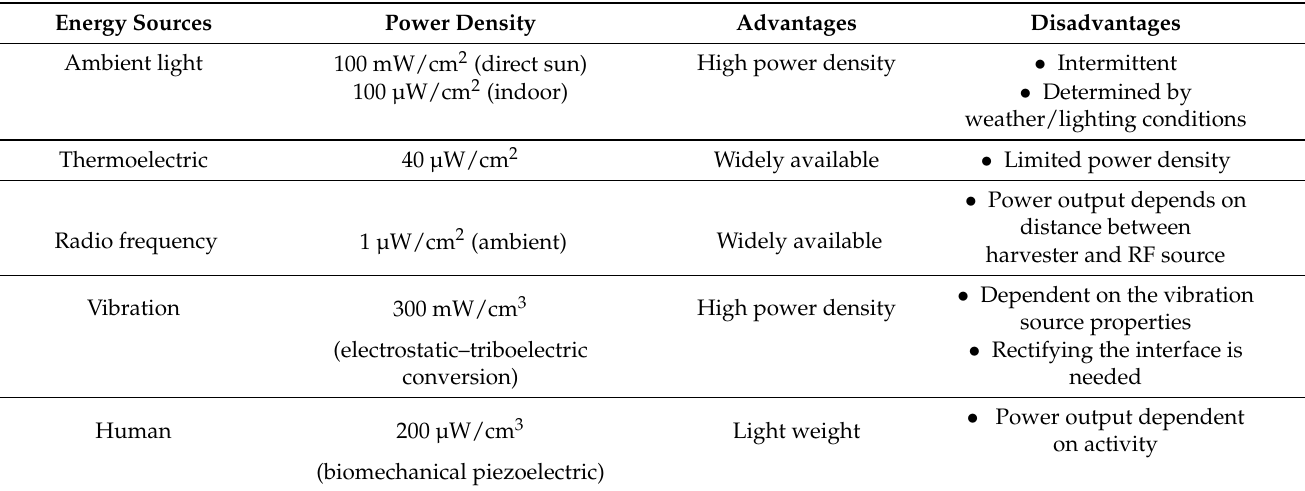
Table 7. Energy sources for supplying wearable devices (literature